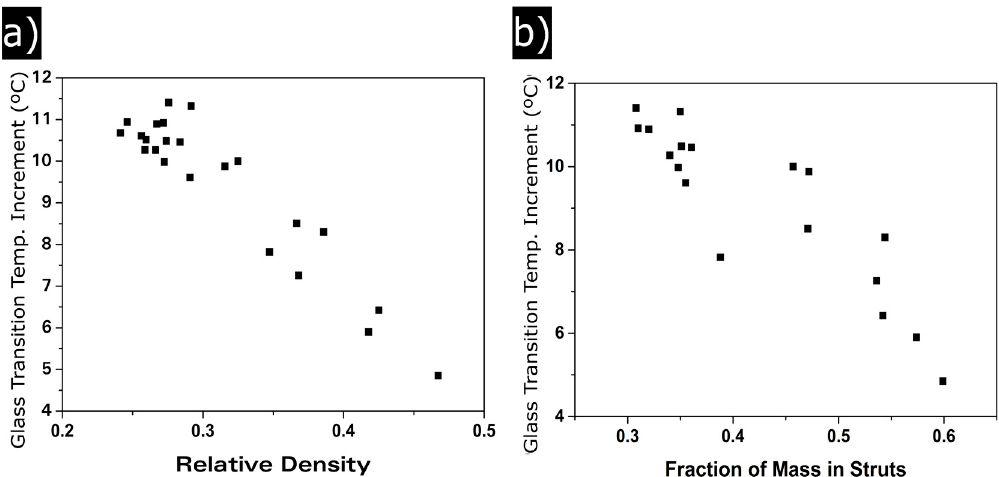
Figure 11. ( a ) glass transition temperature increment as a function of relative density; ( b ) glass transition temperature as a function of the fraction of mass in struts.